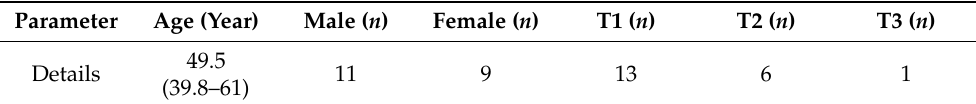
Table 1. The clinical parameters of pRCC patients included in